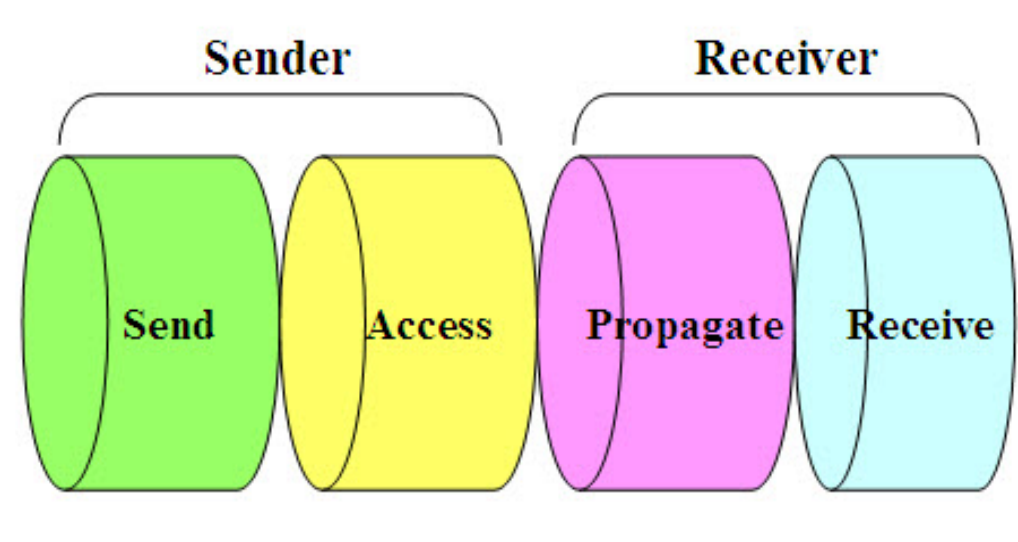
Figure 2. Decomposition of packet delay over a wireless